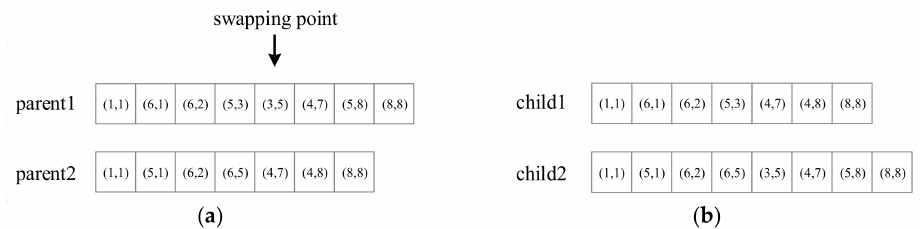
Figure 17. Chromosomes of crossover operation ( a ) two parents’ chromosomes; ( b ) generated chromosomes via crossover operation.